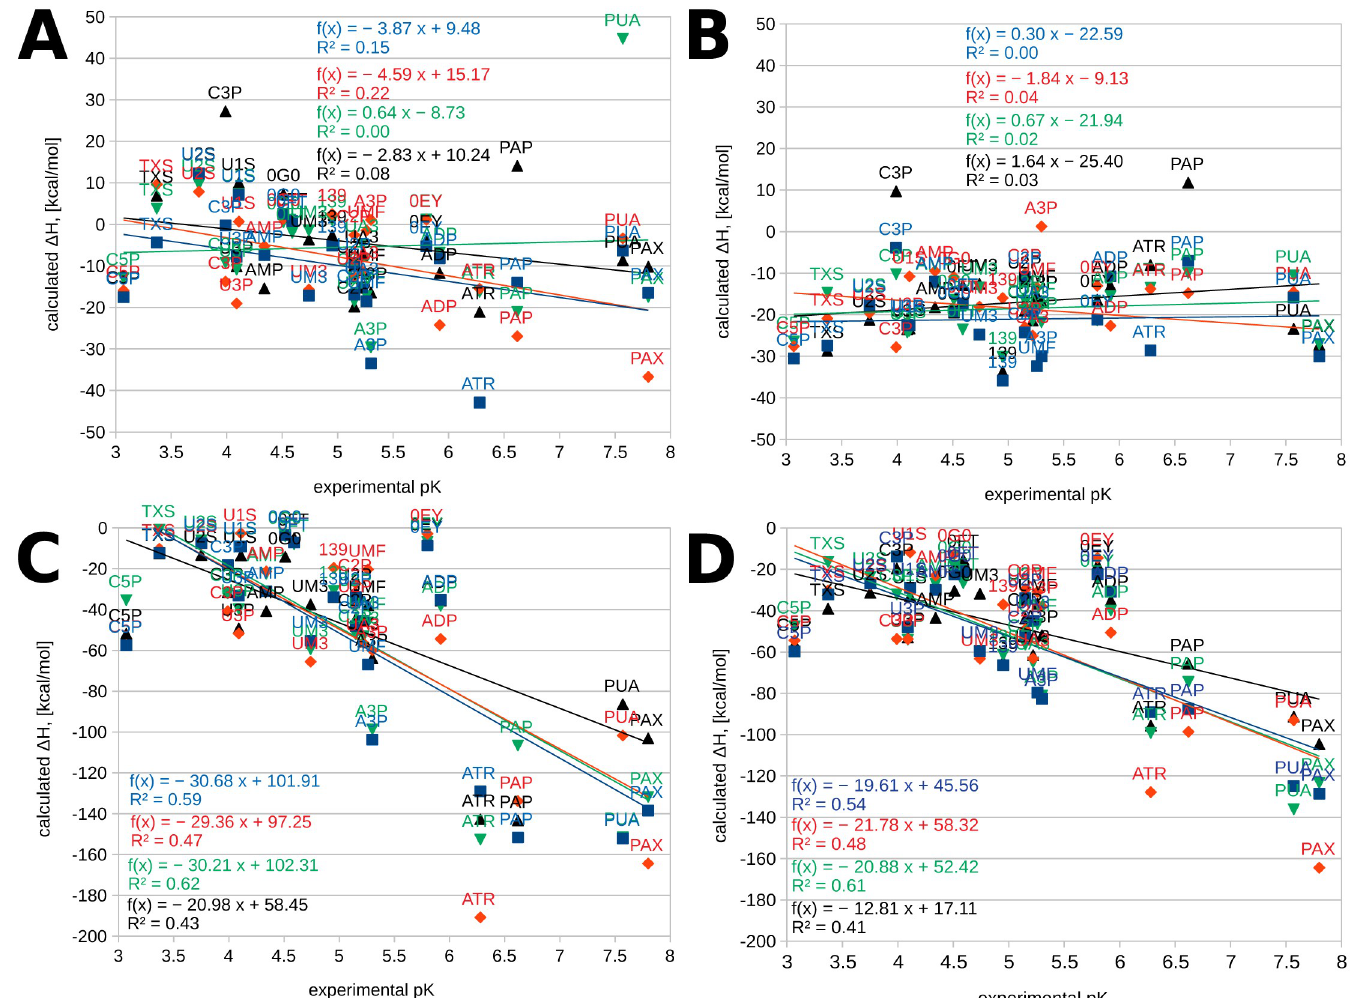
Fig 6. Δ H/p K correlations. (A) Correlations between computed enthalpy ( Δ H) and experimental affinity from the MM-PBSA calculations from replica 1 (blue), replica 2 (red), replica 3 (green), and replica 4 (black); bridging waters and ions are not included in the calculations. For each replica, the line of best fit and the corresponding equation are also given in the respective color. (B) Correlations between computed enthalpy ( Δ H) and experimental affinity from the MM-GBSA calculations from replica 1 (blue), replica 2 (red), replica 3 (green), and replica 4 (black); bridging waters and ions are not included in the calculations. For each replica, the line of best fit and the corresponding equation are also given in the respective color. (C) Correlations between computed enthalpy ( Δ H) and experimental affinity from the MM-PBSA calculations from replica 1 (blue), replica 2 (red), replica 3 (green), and replica 4 (black); bridging waters and ions are included in the calculations. For each replica, the line of best fit and the corresponding equation are also given in the respective color. (D) Correlations between computed enthalpy ( Δ H) and experimental affinity from the MM-GBSA calculations from replica 1 (blue), replica 2 (red), replica 3 (green), and replica 4 (black); bridging waters and ions are included in the calculations. For each replica, the line of best fit and the corresponding equation are also given in the respective